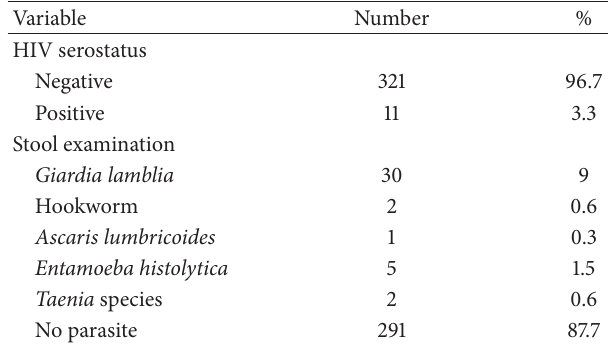
Table 3: Laboratory findings of ANC attendees in government